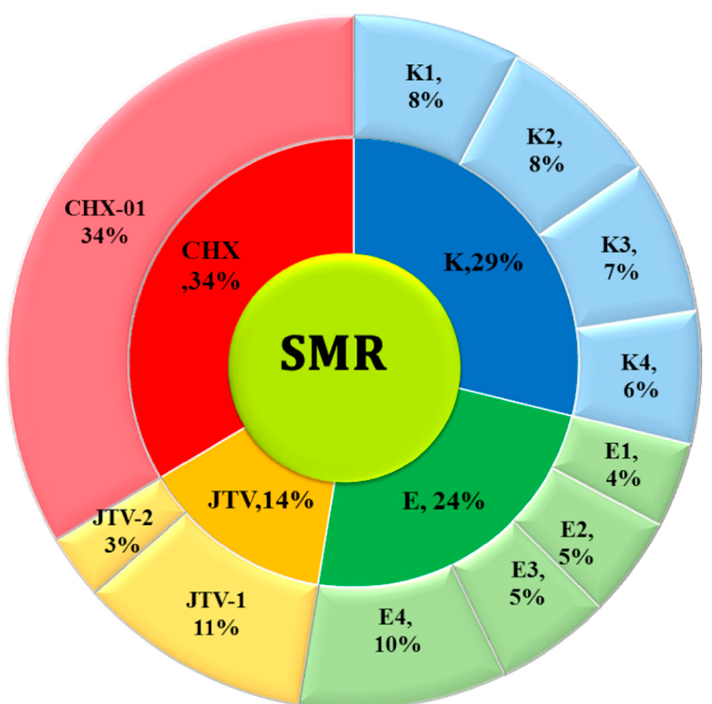
Figure 9. Percentage of exergy destruction by each equipment in the optimized case of the SMR LNG process.